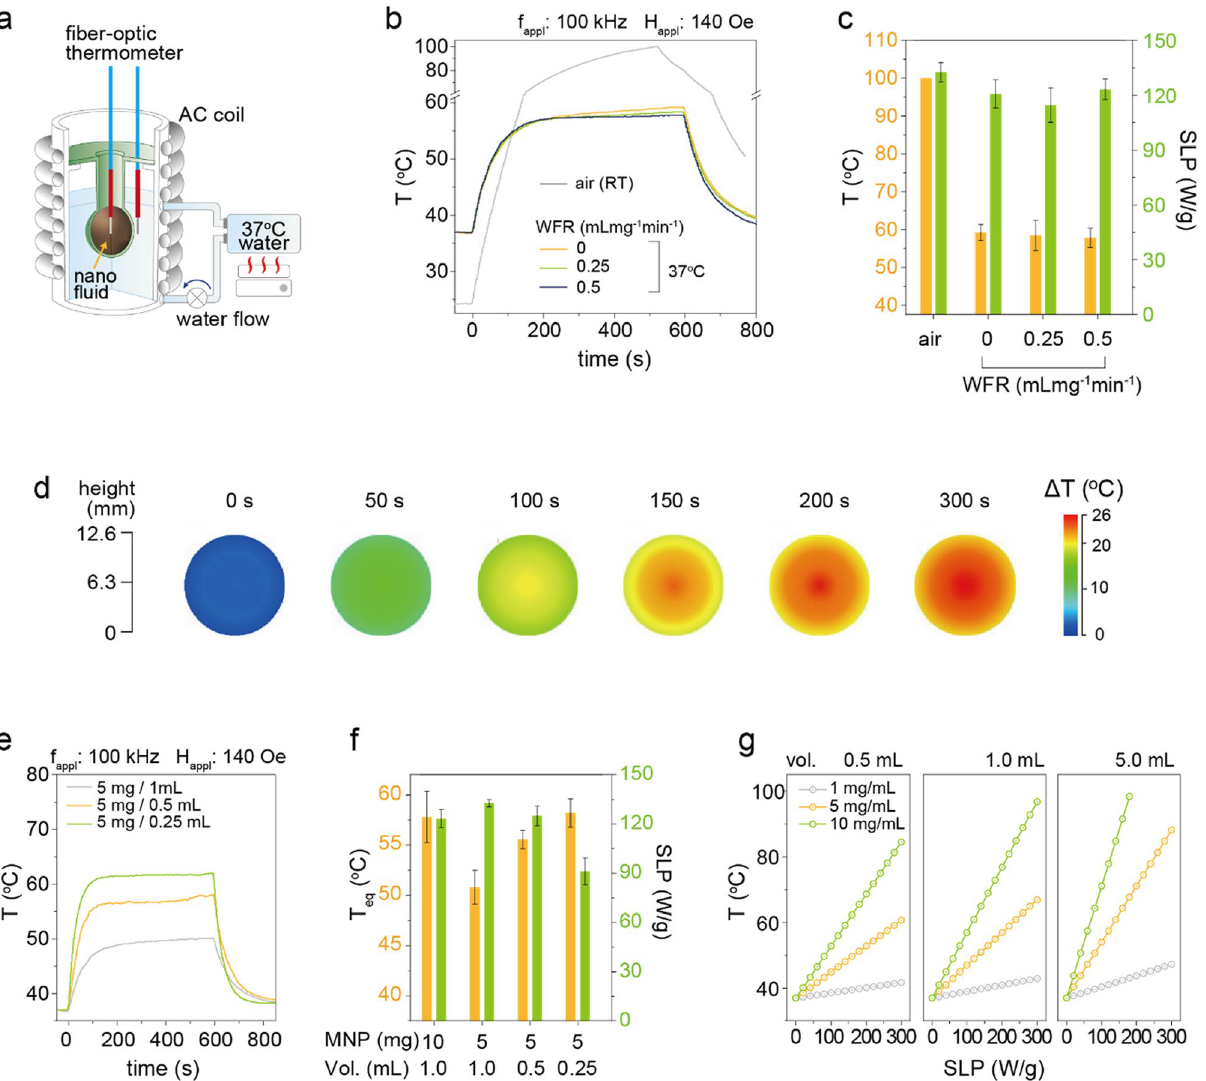
Figure 3. Effects of surrounding medium on the ΔT and SLP of MNs. ( a ) A schematic illustration of the experimental setup. The temperature and volume of surrounding water are 37 °C and 40 mL, respectively. The water flow rate (WFR) is controlled by a peristaltic pump. ( b ) The AC heating temperature rising characteristics of Mg doped γFe 2 O 3 MNs measured at the different surrounding medium conditions of air (RT, 23 °C) and 37 °C water with 0, 0.25, and 0.5 mL mg −1 min −1 WFR. ( c ) The heating-up temperature (orange) and SLP (green) obtained from different surrounding medium conditions. ( d ) The temperature distribution of 1 mL Mg doped γFe 2 O 3 MN in spherical-shape sample container during the application of AC magnetic field for 5 min. (WFR = 0.25 mL mg −1 min −1 ). ( e – g ) The heat transfer coefficient measurement and calculated equilibrium temperature. The AC heating temperature rising characteristics of Mg doped γFe 2 O 3 MNs ( e ), equilibrium temperature (orange), and SLP (green) measured at the different concentrations (5–20 mg mL −1 ) and volumes (0.25–1.0 mL) ( f ). Calculated equilibrium temperature at the different concentrations and volumes as a function of SLP ( g